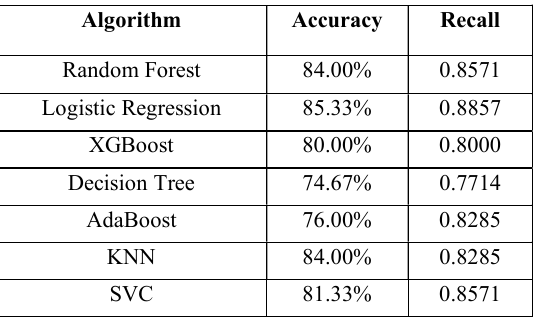
Table 1: Model Accuracies for Heart (Before Parameter Tuning)